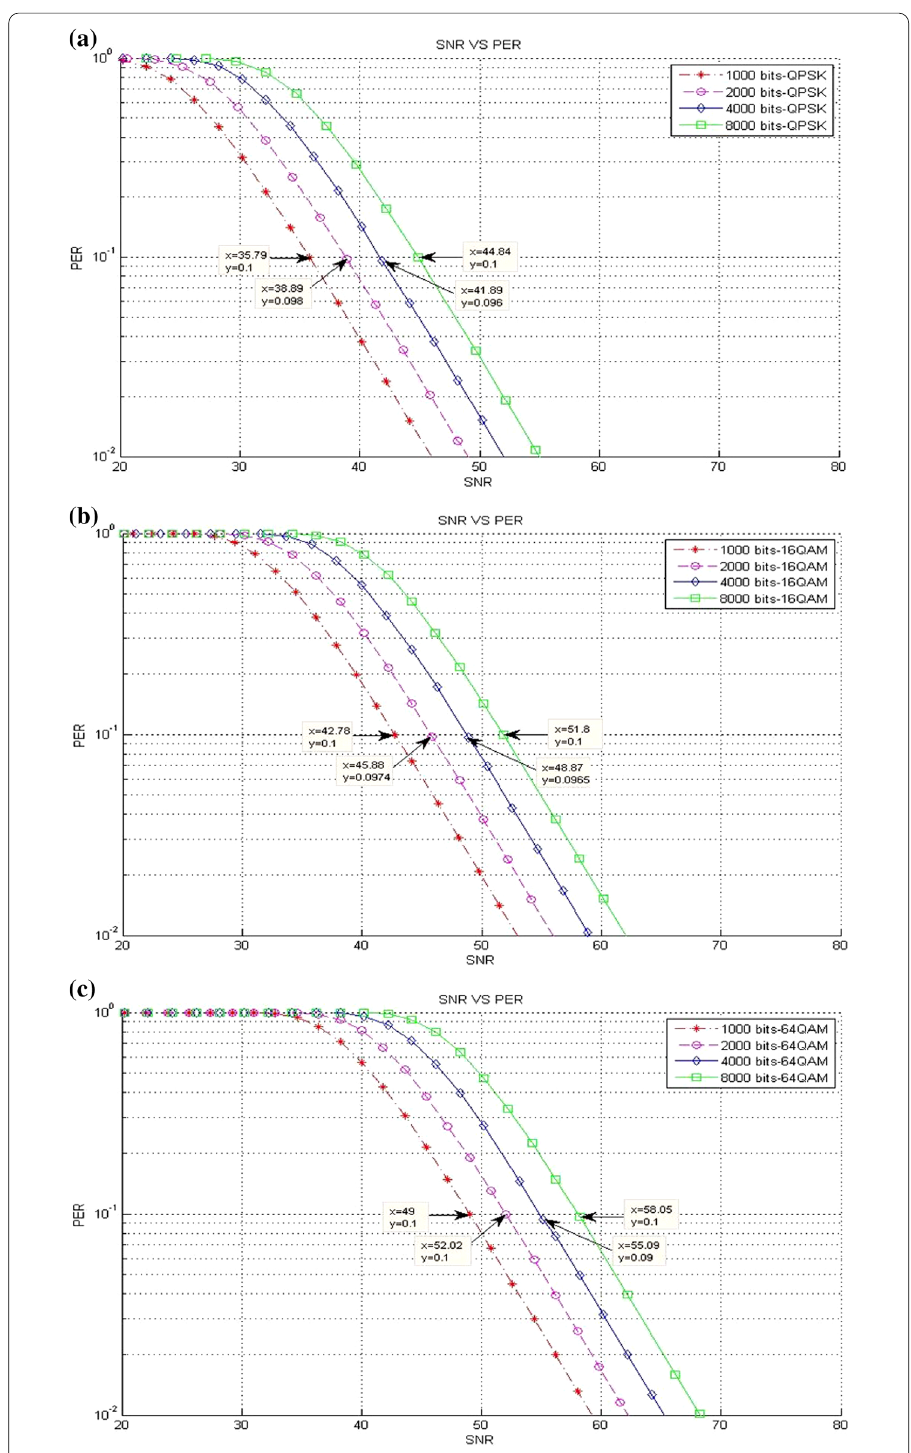
Fig. 13 a QPSK, b 16‑QAM, c 64‑QAM ( a – c ) packet loss of SNR threshold values for different modulation types and various packet sizes in the MDP‑CLLA